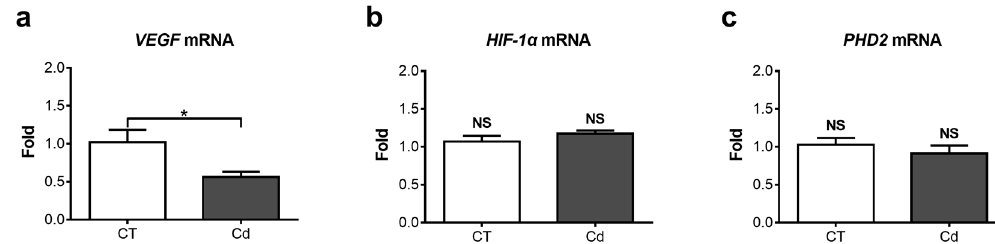
Figure 2. mRNA expression of ( a ) vascular endothelial growth factor ( VEGF ) (* p = 0.0266, Mann–Whitney U-test), ( b ) HIF-1 α ( p = 0.1379, Mann–Whitney U-test), and ( c ) PHD2 ( p = 0.4083, Student’s t -test) in kidneys of fetuses from control (CT) and cadmium (Cd) groups. Data were normalized with